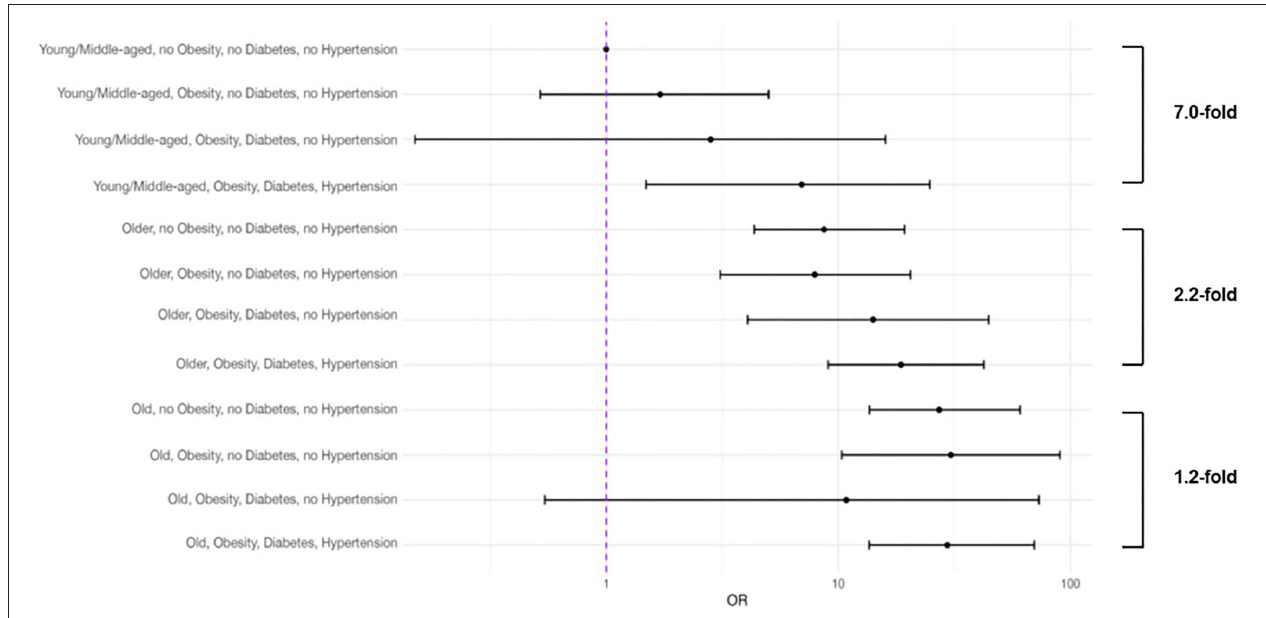
FIGURE 2 | Multivariable relationships of selected anthropometrics, comorbidities and laboratory parameters with COVID-19-related mortality in three age groups based on the presence (unhealthy) or absence (healthy) of obesity, diabetes and hypertension. All COVID-19 patients who recovered and died ( n = 3,163) were first divided in three age groups (young and middle aged, 18–55 years, n = 1,068; older age, 56–75 years; n = 1,220 and old age, > 75 years; n = 875) and subsequently divided in two groups ( n = 1,357) based on the presence (unhealthy) or absence (healthy) of obesity (BMI ≥ 30 kg · m − 2 ), and impaired metabolic health (diabetes and hypertension). All parameters shown were included in the multivariable regression